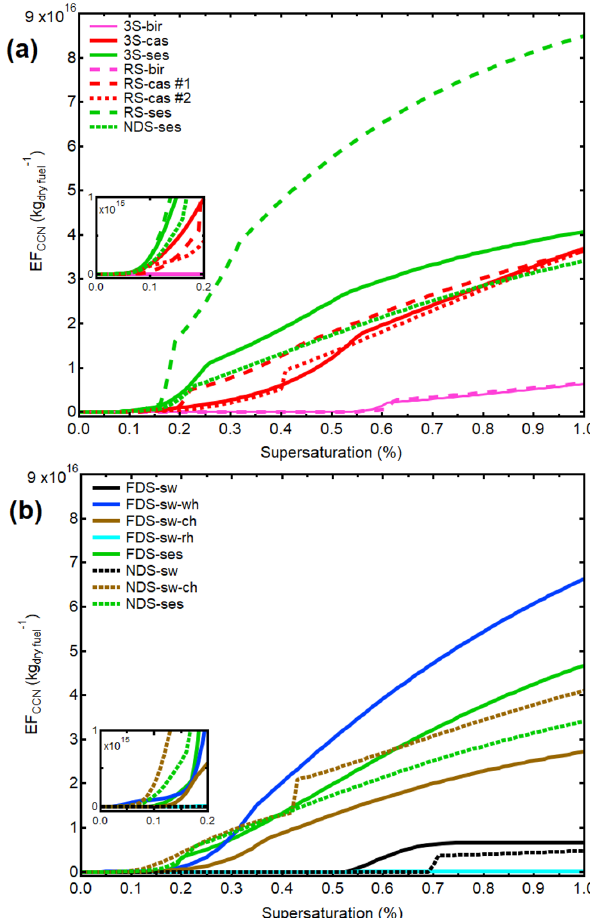
Figure 5. Normalised average “primary” CCN emission factors vs. supersaturation for various combinations of stoves and fuels. The curves are inferred from the average particle number size distribu- tions during which the chamber was filled (Fig. 2) combined with the inter- and extrapolated CCN activity, which typically was mea- sured for three (2–4) particle mobility sizes (Fig. 3). The NDS-ses emission factors are included in both (a) and (b) for